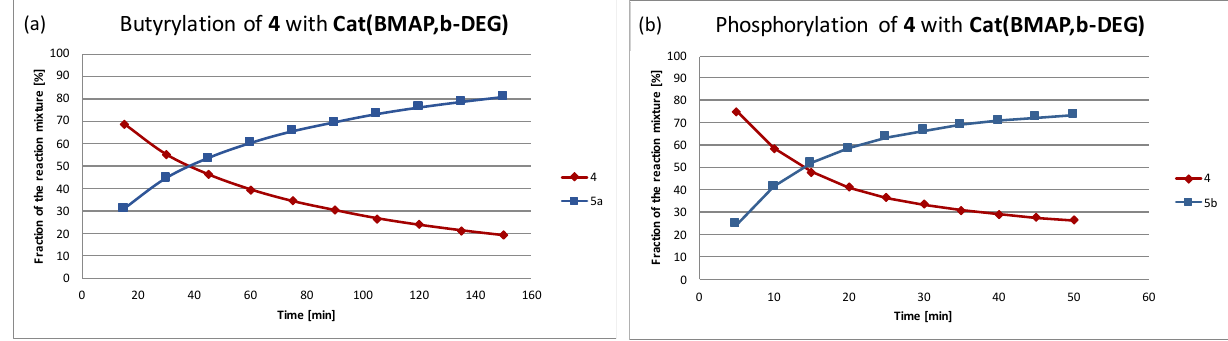
Figure 1. Typical monitoring of the reaction progress: ( a ) butyrylation of 4 ; ( b ) phosphorylation of 4 . Butyrylation reaction conditions: 0.2 mmol of substrate 4 , 0.4 mmol of butyric anhydride, and 0.005 mmol (5 mol%) of Cat(BMAP,b-DEG) in 10 mL benzene at room temperature. Phosphorylation reaction conditions: 0.2 mmol of substrate 4 , 0.25 mmol of diphenylphosphoryl chloride, 0.25 mmol DIPEA, and 0.005 mmol (5 mol%) of Cat(BMAP,b-DEG) in 10 mL benzene at room temperature.